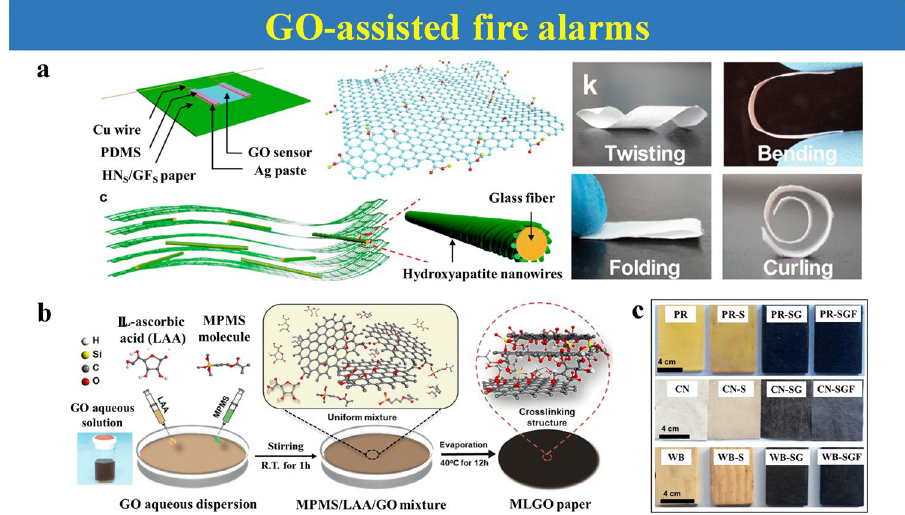
Fig. 6 a Schematic fabricating process and micro‑structure of fire alarm wallpaper, GO structure with rich oxygen‑containing groups, and glass fiber paper with multilayered structure. Reproduced with permission from Ref. [80]. Copyright 2018 American Chemistry Society. b Schematic illustration of MPMS/LAA co‑modified GO (MLGO) paper, MLGO paper. Reproduced with permission from Ref. [83]. Copyright 2020 Else‑ vier. c Photographs of the fire‑warning coatings on the surface for different flammable materials: polystyrene resin (PR), cotton (CN), and wood block (WB). Reproduced with permission from Ref. [64]. Copyright 2018